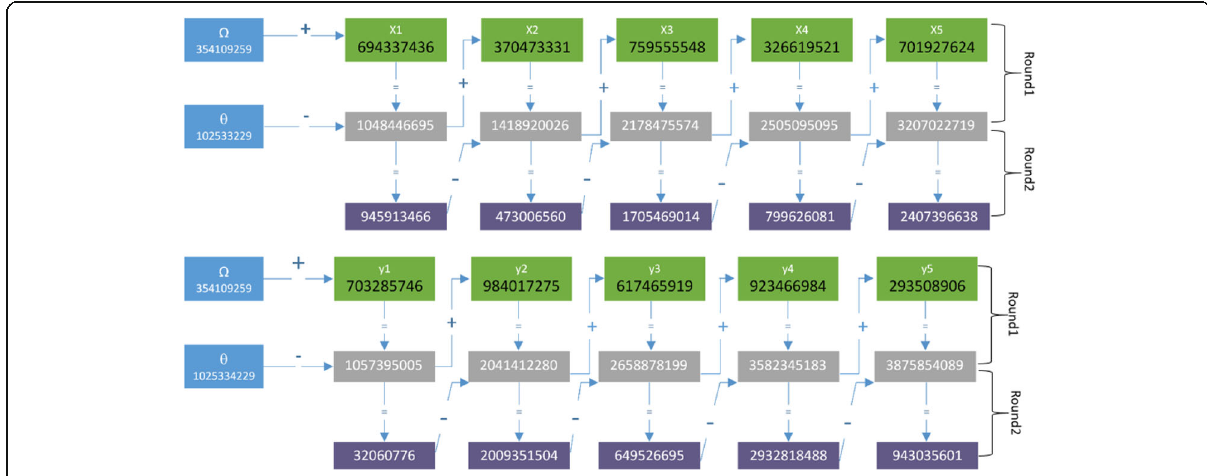
Fig. 1 Hash function mutation of curve points